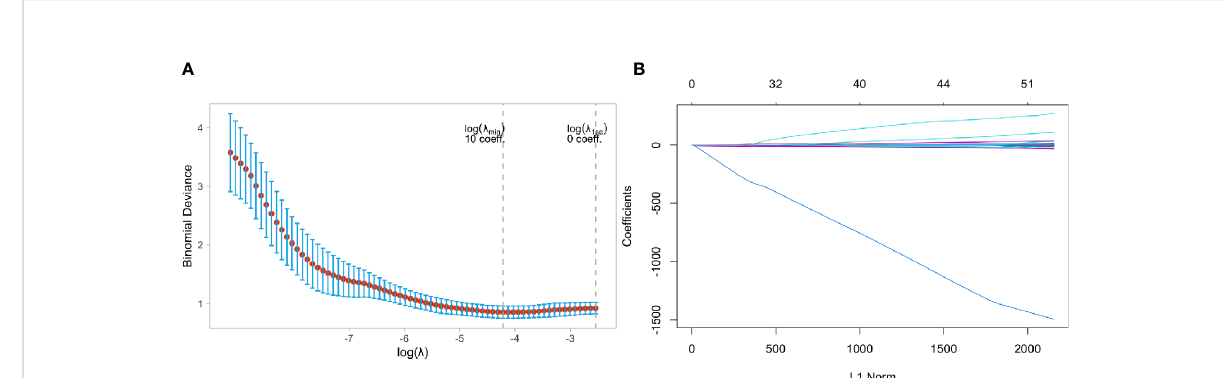
Table 2 showed the prediction performance indicators of the fi ve machine learning models that used the variables chosen by